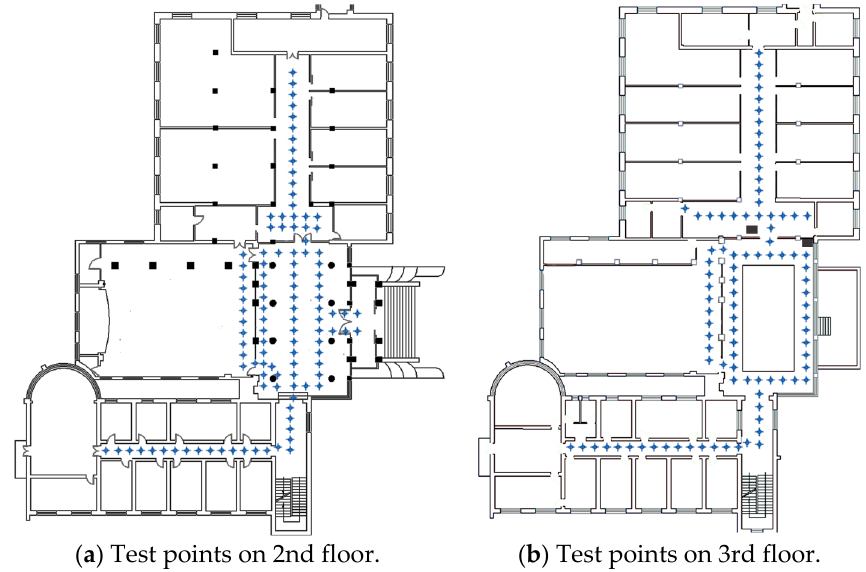
Figure 9. Test environment of the proposed system, which includes second and third floor of a laboratory in Wuhan University. ( a ) Floorplan of second floor, including 109 test points. ( b ) Floorplan of third floor, including 93 test points.